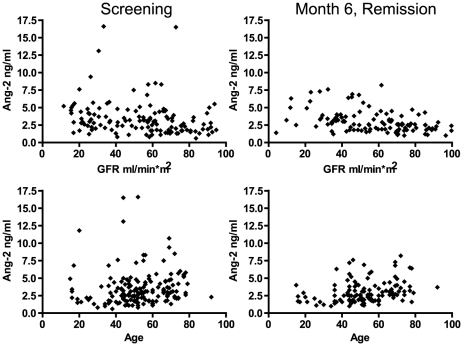
Plots of serum angiopoietin-2 (Ang-2) levels versus GFR (top panels) or age (bottom panels).Samples from subjects in RAVE were assayed at times of active AAV (screening, left panels) and remission 6 months after starting treatment (right panels).